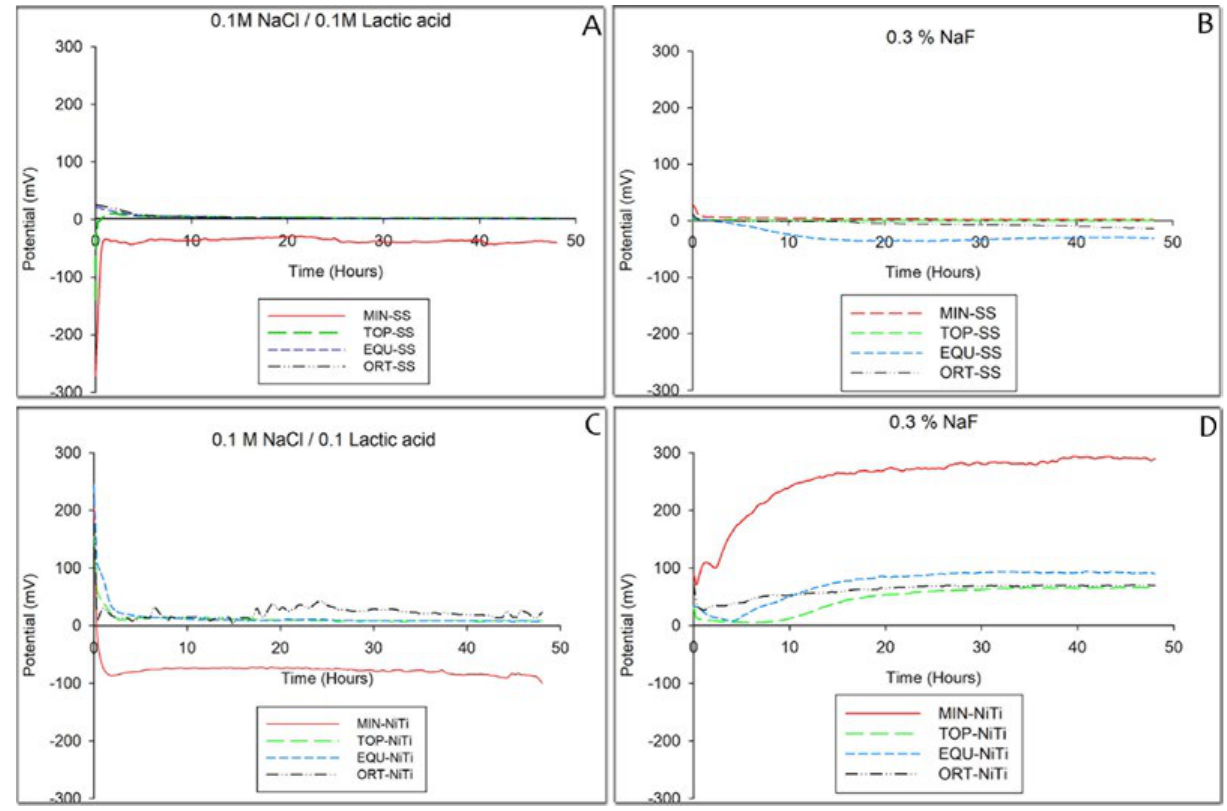
Figure 2. Representative curves from all bracket wire combinations tested showing the potential difference over time for both solutions. A and B depict the curves of bracket-SS wire combinations for 0.1 M NaCl -0.1 M lactic acid solution and 0.3% NaF respectively. C and D show the curves for bracket- NiTi wire combinations.